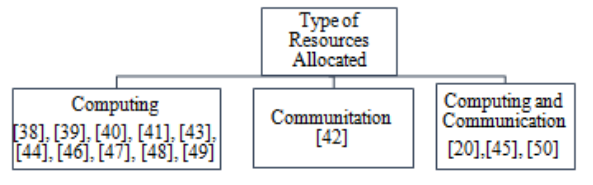
Fig. 3. Resource allocation